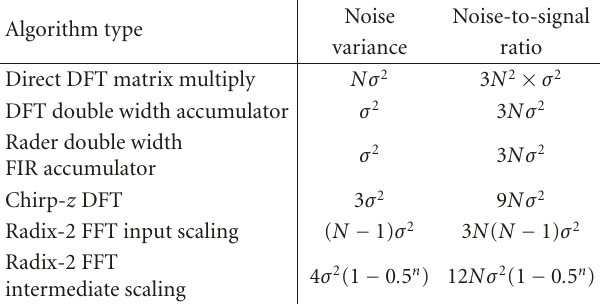
Table 5: Noise in length N = 2 n DFT and FFT algorithms width σ 2 = 2 − 2 B /